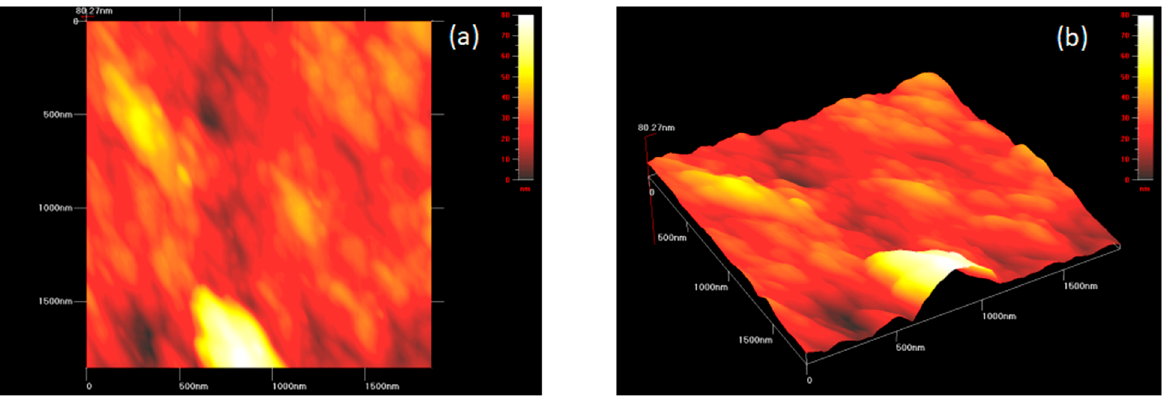
Figure 3. A three-dimensional image of TiO 2 nanoparticles synthesized by Bacillus subtilis obtained using atomic force microscope at ( a ) low resolution and ( b ) high resolution.